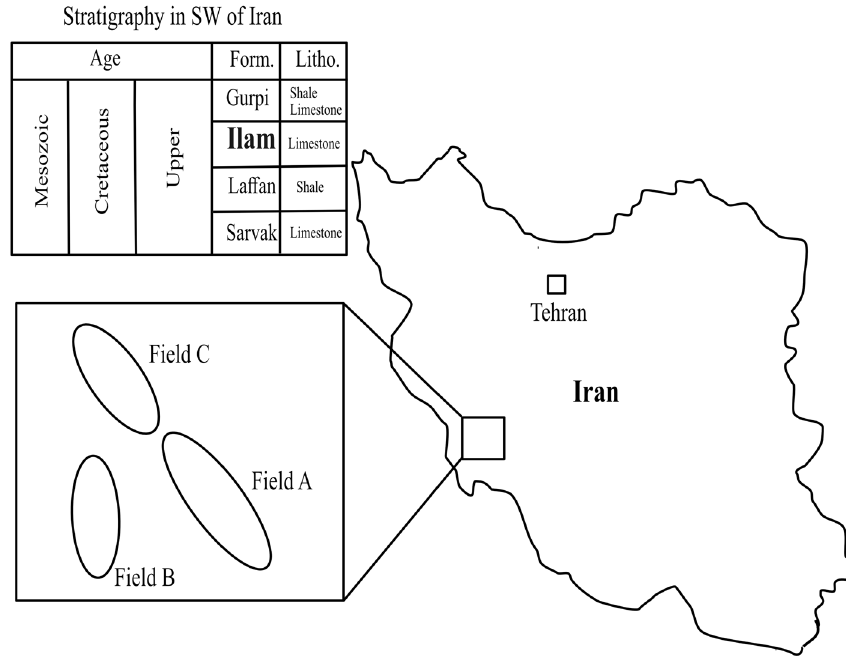
Fig. 2 Geographical location and stratigraphy (Bordenave and Hegre 2010) of the fields under